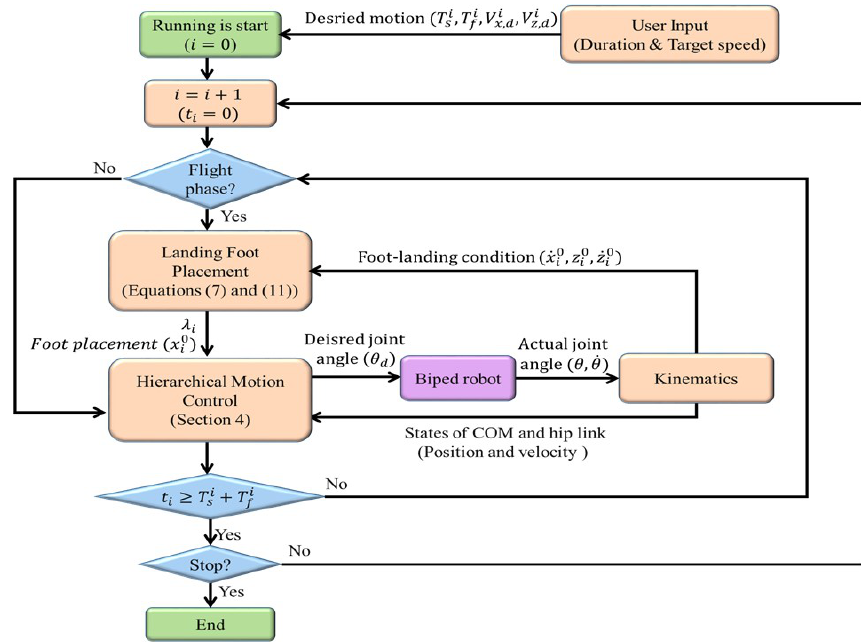
Figure 3. Flow chart about trajectory planning